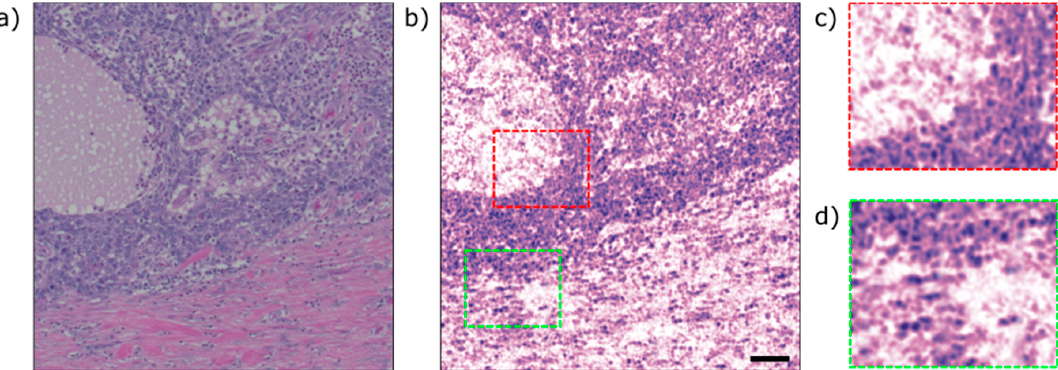
Figure 5. A comparison between a PARS image of unstained human breast tissue with conventional bright-field microscope. ( a ) a standard H&E stained image ( b ) a PARS mosaic of one hundred frames, total field of view of 1 × 1 mm 2 ( c , d ) zoomed in versions of ( b ) showing cell nuclei. The image was acquired with a 266 nm excitation source operating at 20 kHz. Scale bar 100 µm. Table 1. Summary of results of the proposed system .